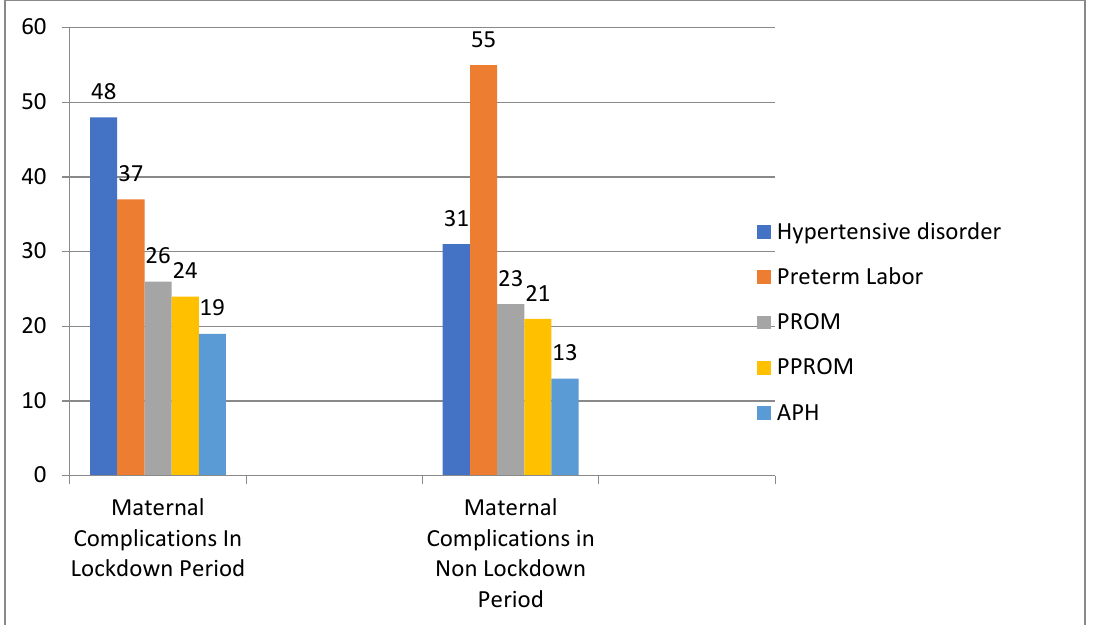
Figure 2: Types of maternal complications seen during the lockdown and the non-lockdown periods.